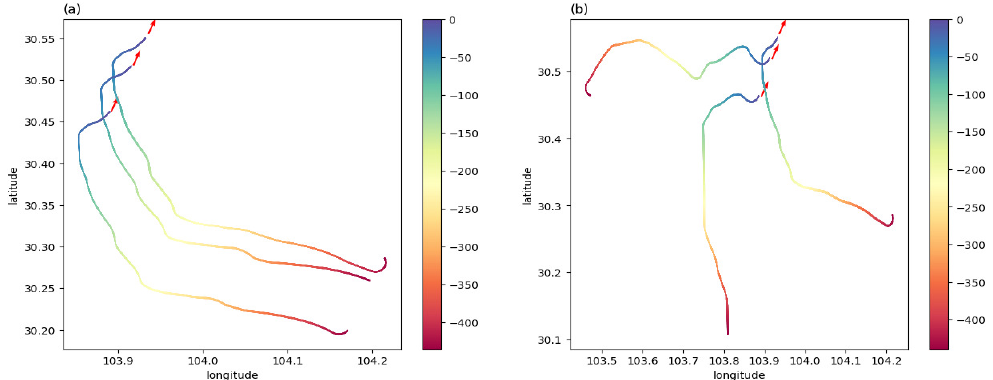
Figure 14. Color maps of aircraft trajectories: ( a ) three aircraft starting in the same aerospace, flying to the aimed for 4D waypoints, respectively, and ( b ) three aircraft starting in different aerospaces, flying to the aimed for 4D waypoints, respectively.